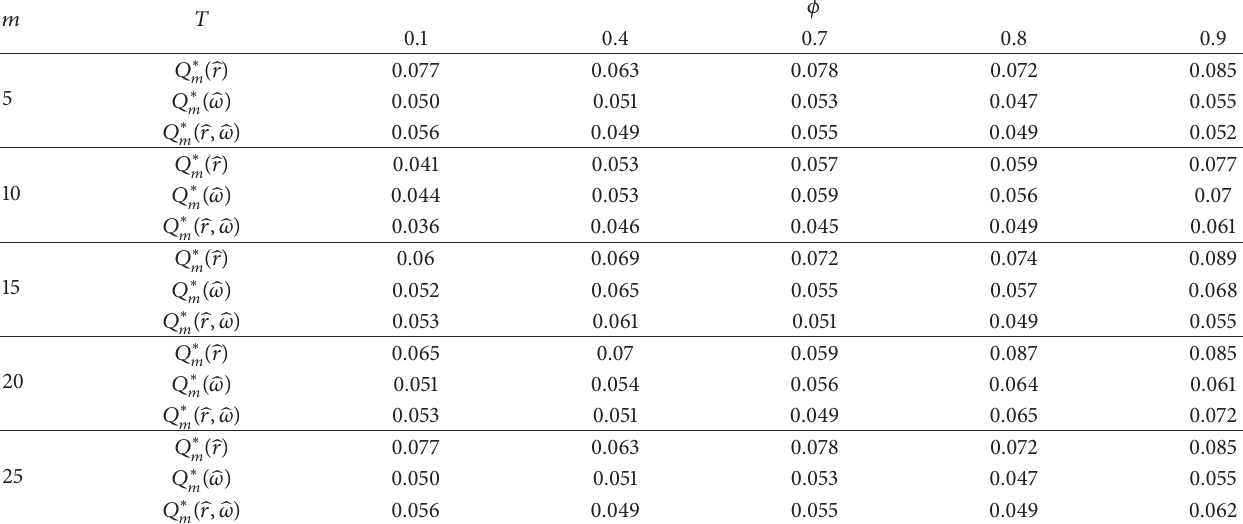
Table 3: Empirical size at 5% nominal size for an AR (1) process: 𝑦 𝑡 = 𝜙𝑦 𝑡−1 + 𝜀 𝑡